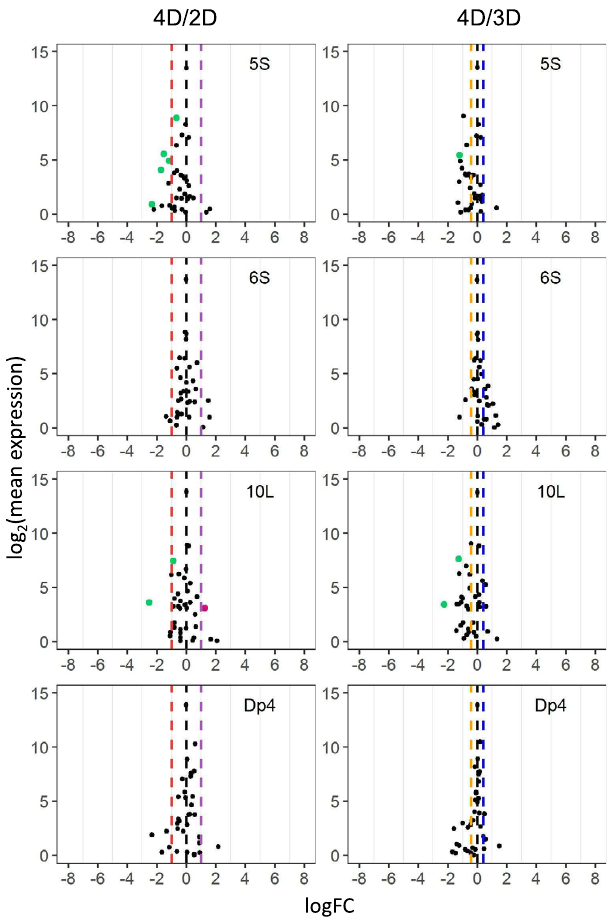
Fig. 4 Scatter plots of trans MIRNA expression in each tetrasomy compared with diploids (4D/2D) or trisomies (4D/3D). Analysis was conducted as described in Fig. 2. FCs of 0.5 (4D/2D) and 0.75 (4D/3D) represent the inverse ratio of MIRNA expression in trans , whereas 2.0 (4D/ 2D) and 1.33 (4D/3D) represent a positive modulation. These FC values are demarcated with labeled vertical lines in red (0.5), orange (0.75), black (0), blue (1.33), and purple (2.0). Source data are provided in Supplementary Data